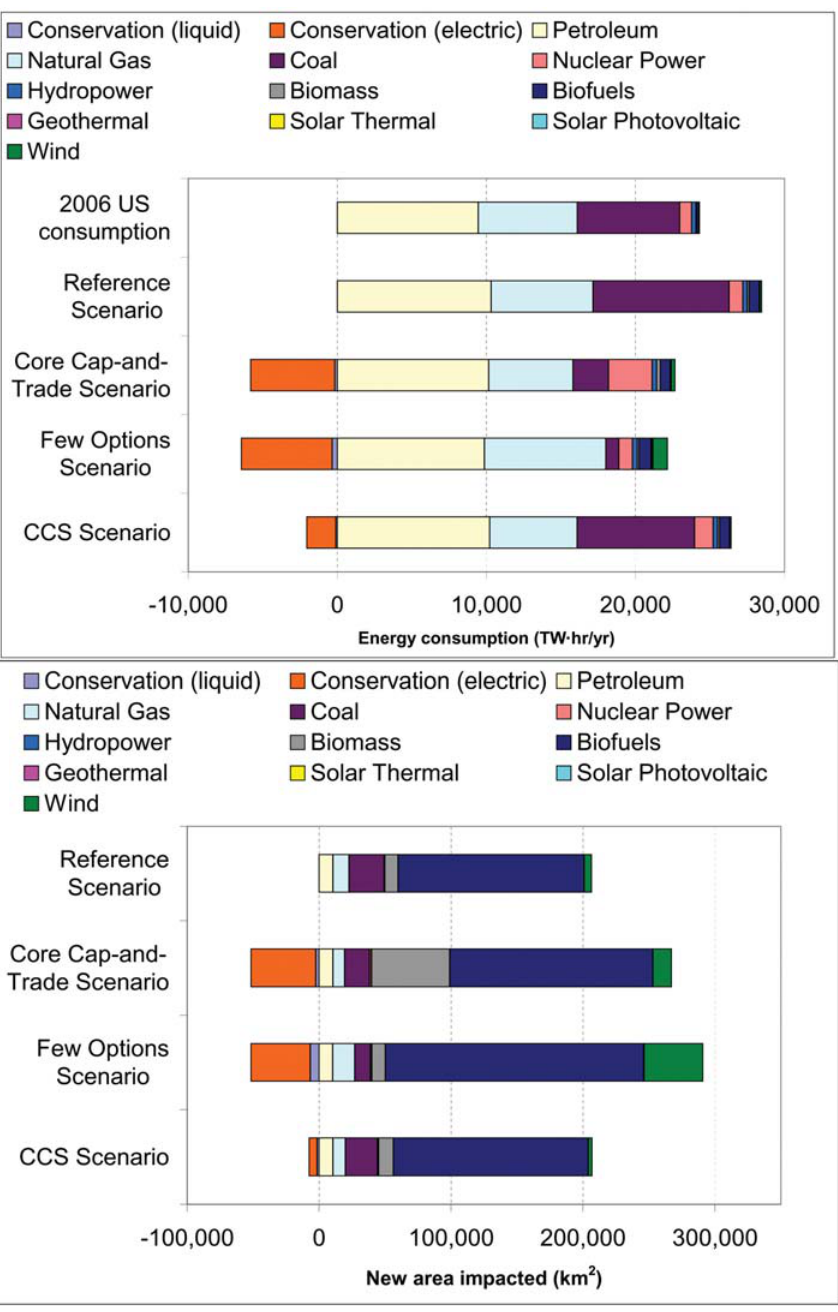
Figure 1. U.S. energy consumption and total new area impacted. (A) U.S. energy consumption in 2006 and under four EIA scenarios. Energy conservation of liquid fuels and electricity, calculated relative to the Reference scenario, are shown as negative since they reduce consumption. (B) The total new area impacted because of development between 2006 and 2030. The new area impacted, or energy sprawl, is a product of consumption and the land-use intensity values in Figure 3. Energy conservation is calculated based on a scenario-specific weighted-average of the energy mix.